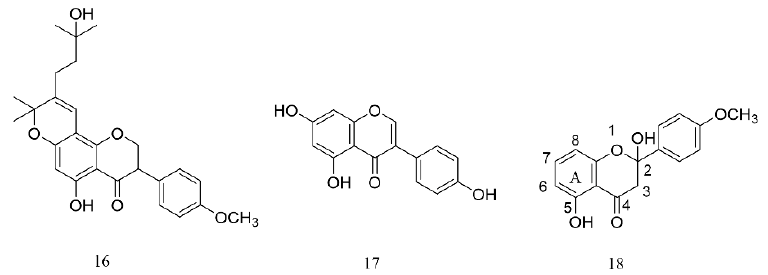
Figure 5. Flavonoids isolated from PA ethanol extract [57,58].